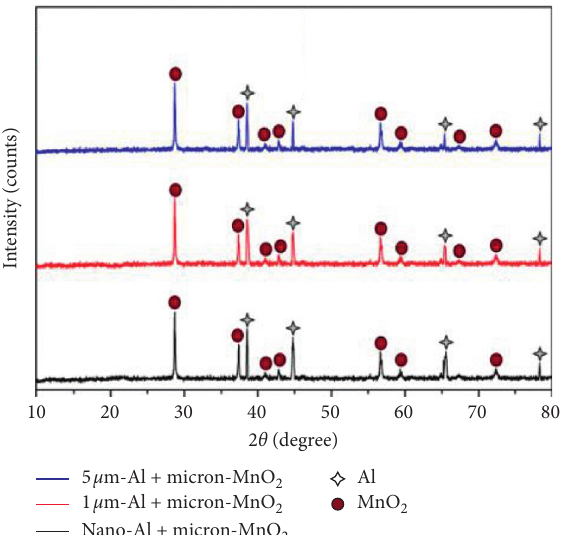
Figure 5: XRD pattern of the thermite samples.